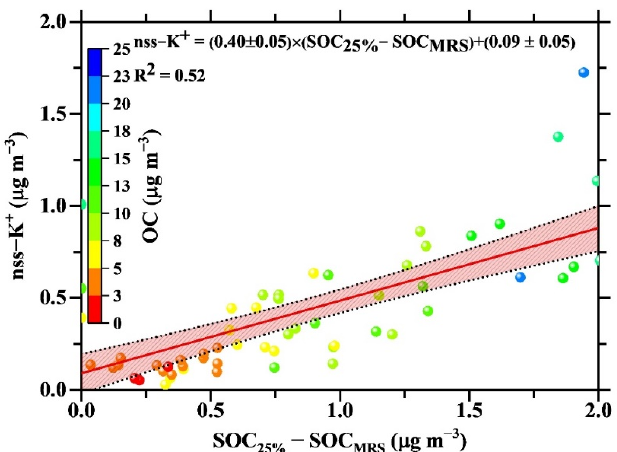
Figure 5. Correlation between the differences in SOC concentration derived from the 25th percentile and MRS methods with nss-K + as a function of the OC concentration (colored scale) in Nainital. The red line shows the linear regression and the red shaded area the limits of the linear regression at 95% confidence level.